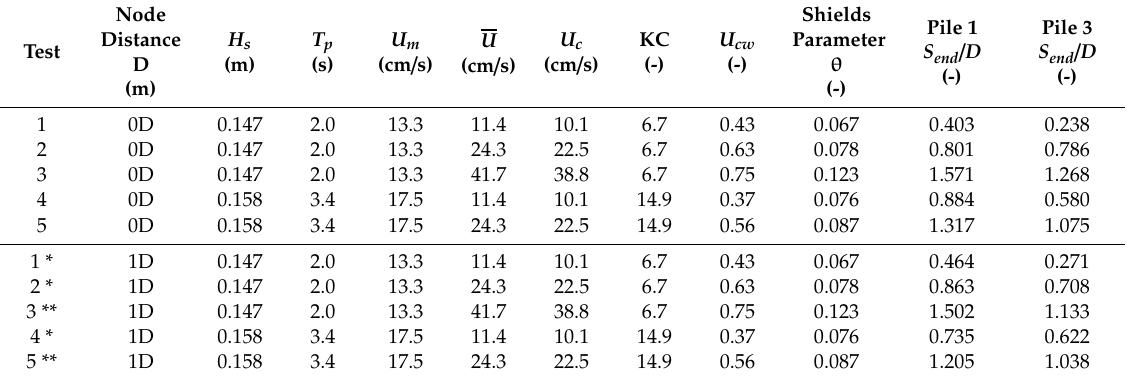
Table 1. Test conditions / measured values, waves are propagating in 90 ◦ to the